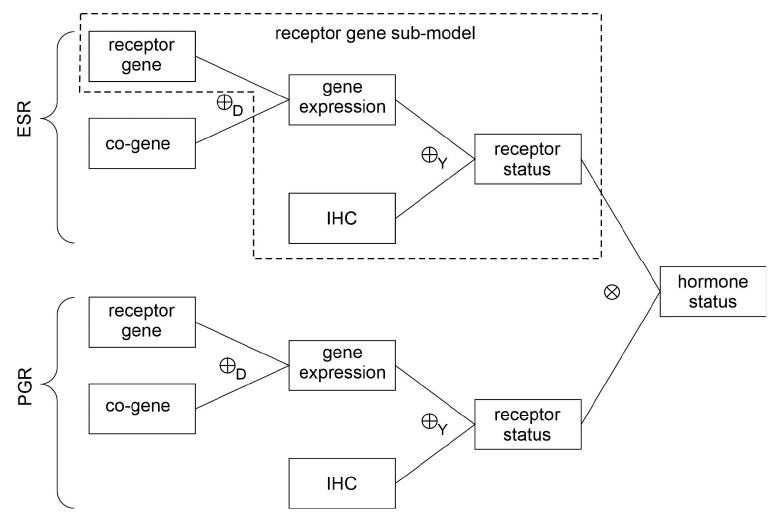
Figure 1. Combining evidence. For estrogen (ESR) and progesterone (PGR) similar procedures are applied to obtain receptor statuses. First evidence for receptor gene and co-gene are combined by Dempster rule ( ⊕ D ) and the result is combined with evidence for IHC by Yager rule ( ⊕ Y ). Finally, receptor statuses for estrogen and progesterone are combined ( ⊗ ) to obtain hormone receptor sta- tus. For detailed illustration of evidence combination (Sections 2.2.1–2.2.4 and Appendix A.6) we start with a ‘receptor gene sub-model’ indicated by the dashed polygon.